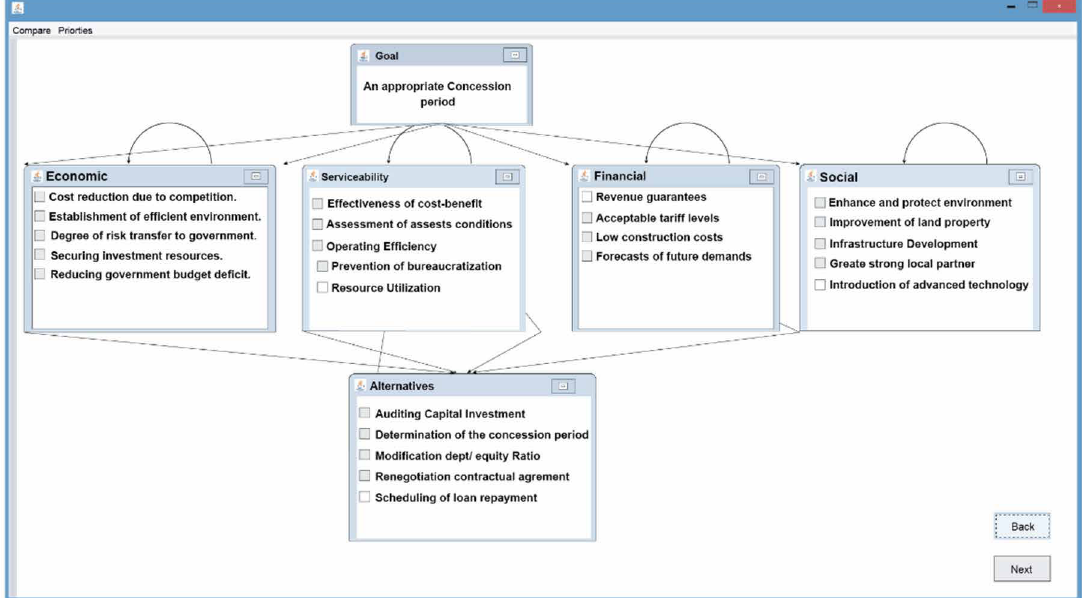
Figure 5. ANP model for key performance indicators evaluation of PPPs